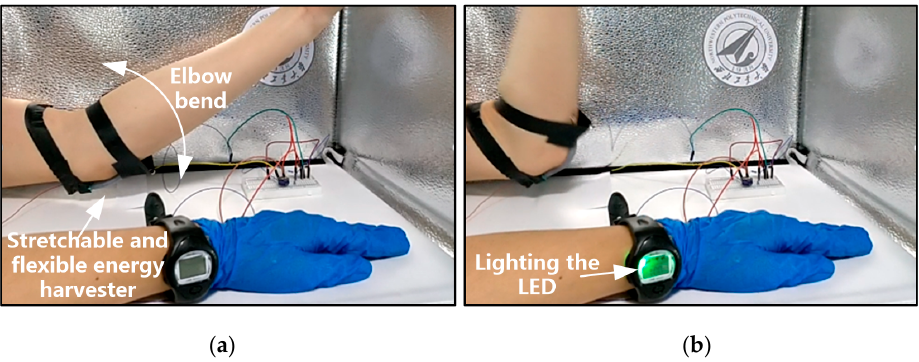
Figure 11. Application of the proposed flexible and stretchable energy harvester in the wearable watch. After wearing the stretchable and flexible energy harvester, the elbow bending action ( a ) could charge the wearable watch ( b ).